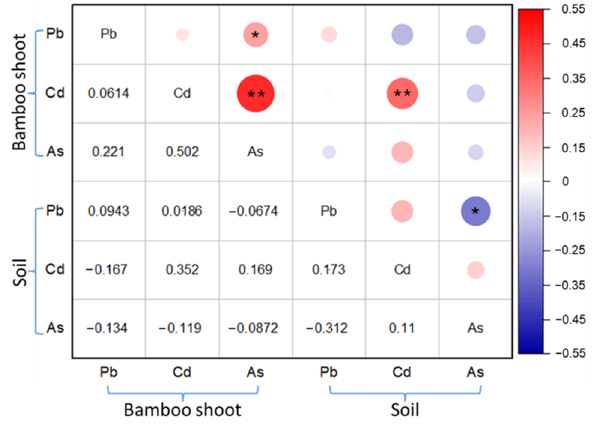
Figure 7. Correlation coefficient between the characteristic heavy metals from soil and bamboo shoots in the corresponding growth environment. ** significant at the 0.01 level; * significant at the 0.05 level.